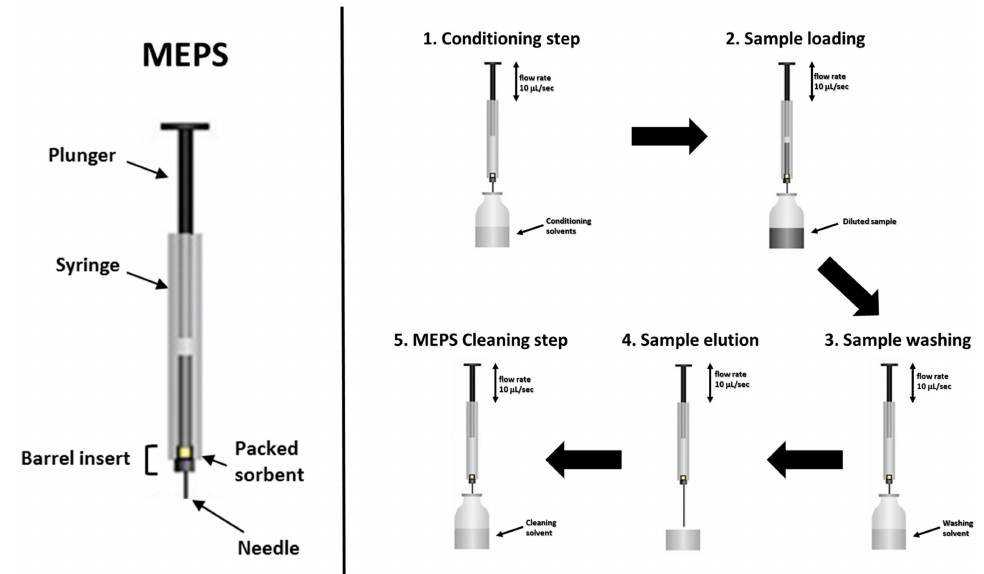
Figure 1. Device ( left ) and general procedure ( right ) applied in MEPS